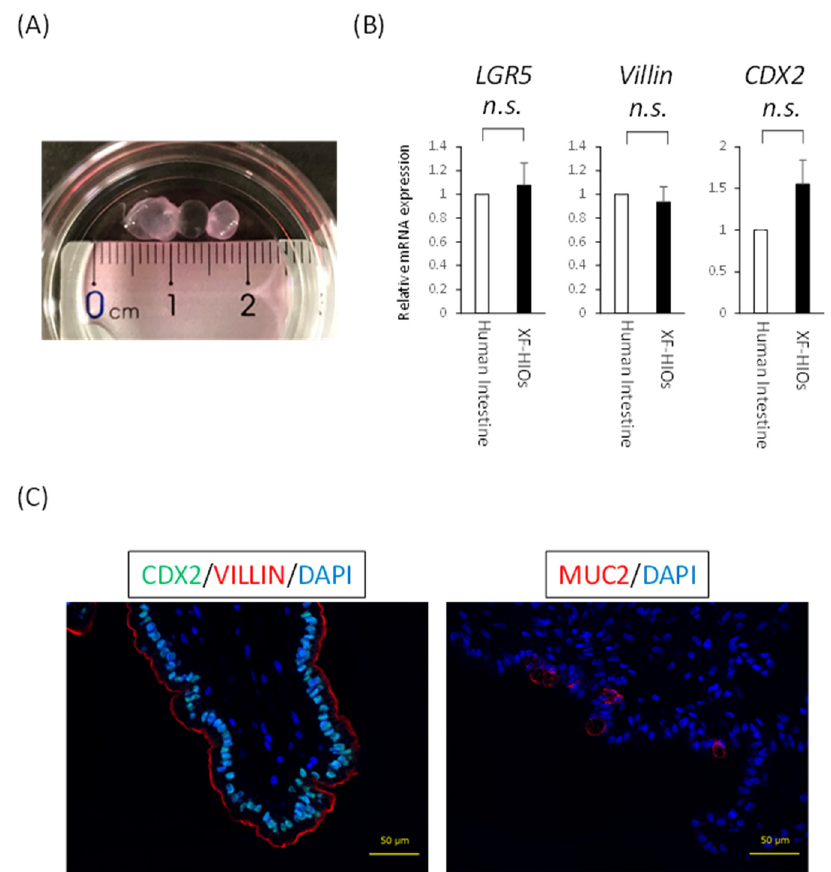
Figure 1. The structures and properties of XF-HIOs. ( A ) A photograph of three-dimensional xenogeneic-free human intestinal organoids (XF-HIOs). ( B ) The level of expression of mRNAs for LGR5 , Villin , and CDX2 relative to that of the human small intestine. Data shown represent the mean ± S.E. values of three independent experiments. n.s.; not significant. ( C ) Immunofluorescent images of XF-HIOs with anti-VILLIN, CDX2, and MUCIN2 (MUC2). DAPI, 4 ′ , 6-diamidino-2-phenylindole. Scale bars: 50 μ m.